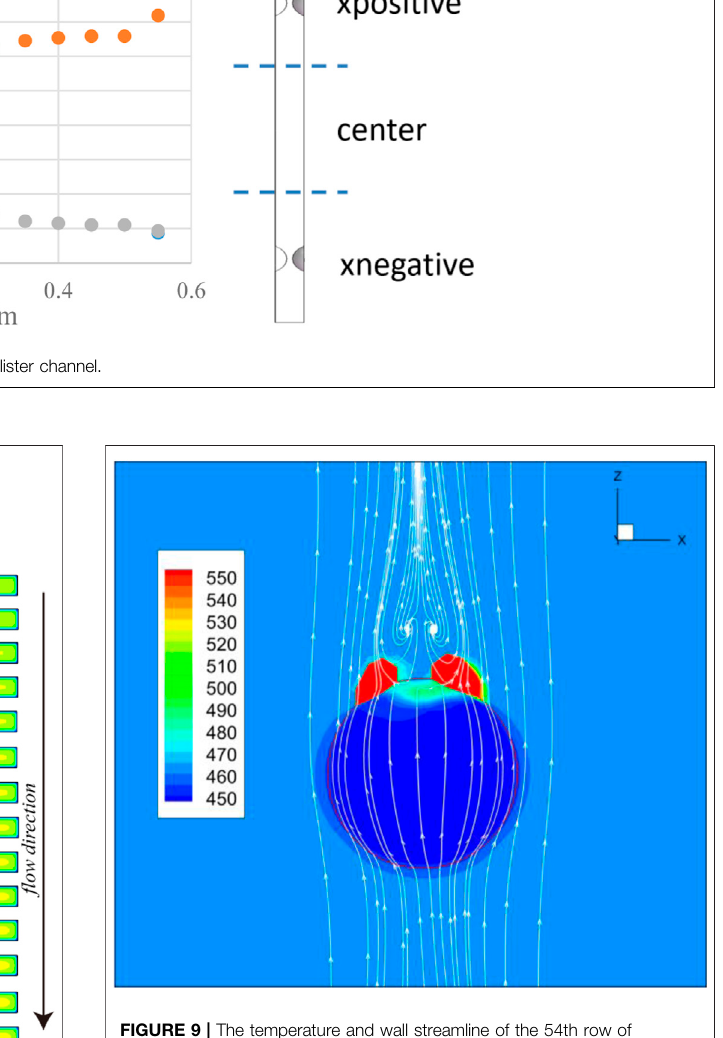
FIGURE 9 | The temperature and wall streamline of the 54th row of blisters for case